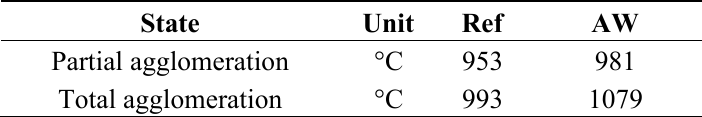
Table 5. Agglomeration temperatures for return sand.